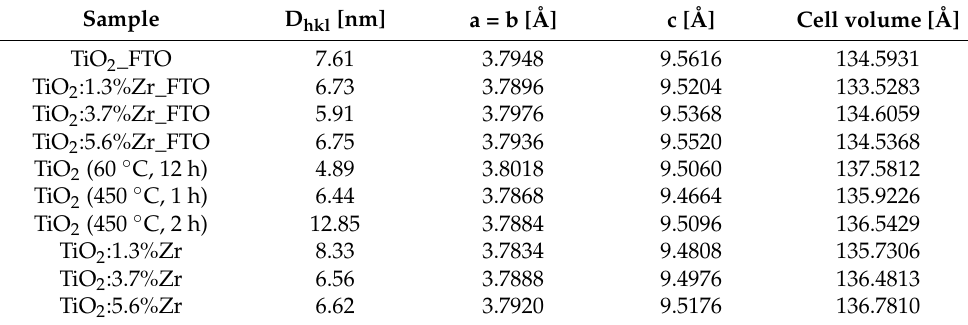
Table 4. Cell parameters of Zr 4+ ions doped TiO 2 nanopowders and layers on